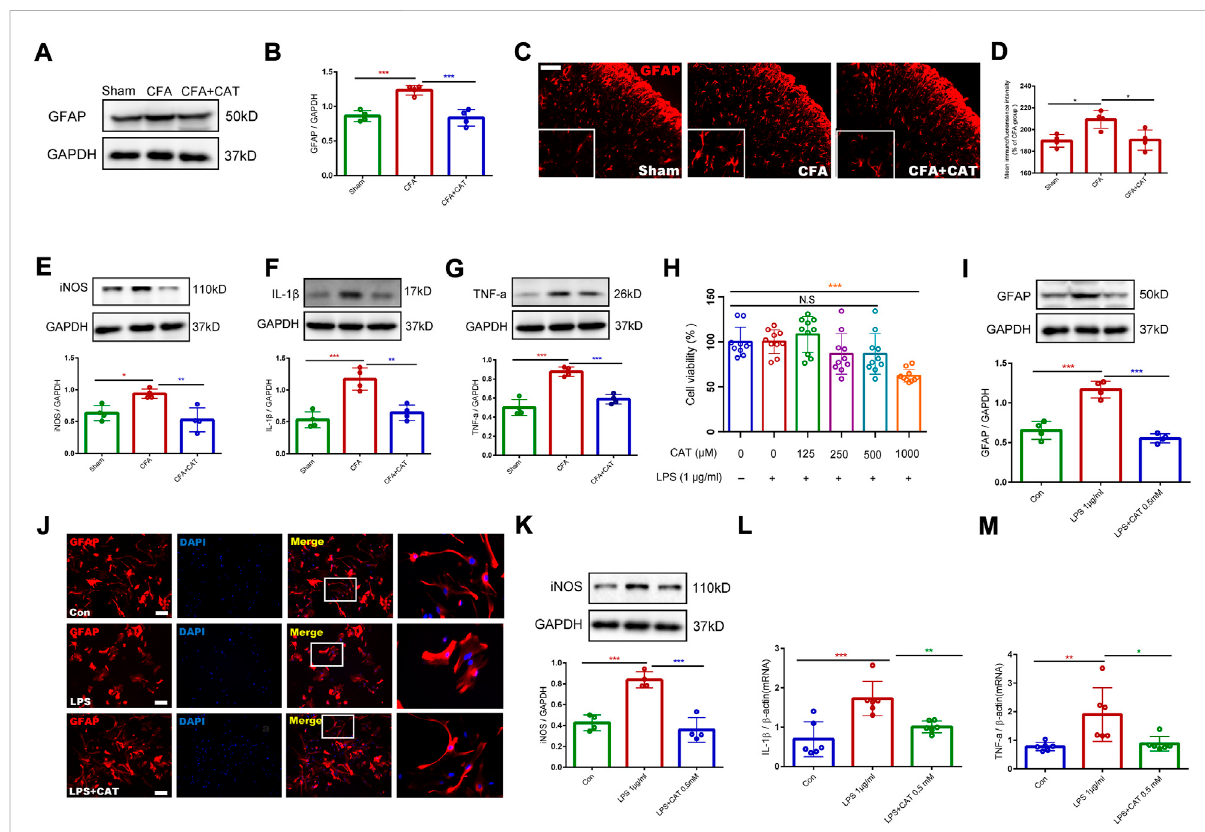
FIGURE 6 Catalpol treatment inhibits the activation of astrocytes and the release of in fl ammatory factors in vivo and in vitro . (A,B). The protein expression of GFAP in the spinal cord of rats were detected by Western blotting. (C,D). The fl uorescence intensity of GFAP in the spinal cord. (* p < 0.05 vs. the CFA group; n = 4, one-way ANOVA). Scale bar = 50 μ m. The relative protein expression of iNOS (E) , IL-1 β (F), and TNF-a (G) in the spinal cord. (* p < 0.05, ** p < 0.01, *** p < 0.001, vs. the CFA group; n = 4, one-way ANOVA). (H). Cell viability was measured using CCK8 assay. (*** p < 0.001 vs. control; one-way ANOVA). (I). The protein expression of GFAP in primary astrocytes. (*** p < 0.001, vs. LPS (1 μ g/ml) group; one-way ANOVA). (J). Immuno fl uorescence results of GFAP in primary astrocytes. Scale bar = 50 μ m. (K). The protein expression of iNOS in primary astrocytes. (L,M). The mRNA expression of IL-1 β and TNF- α in primary astrocytes. (* p < 0.05, ** p < 0.01, *** p < 0.001, vs. LPS (1 μ g/ml) group; one-way